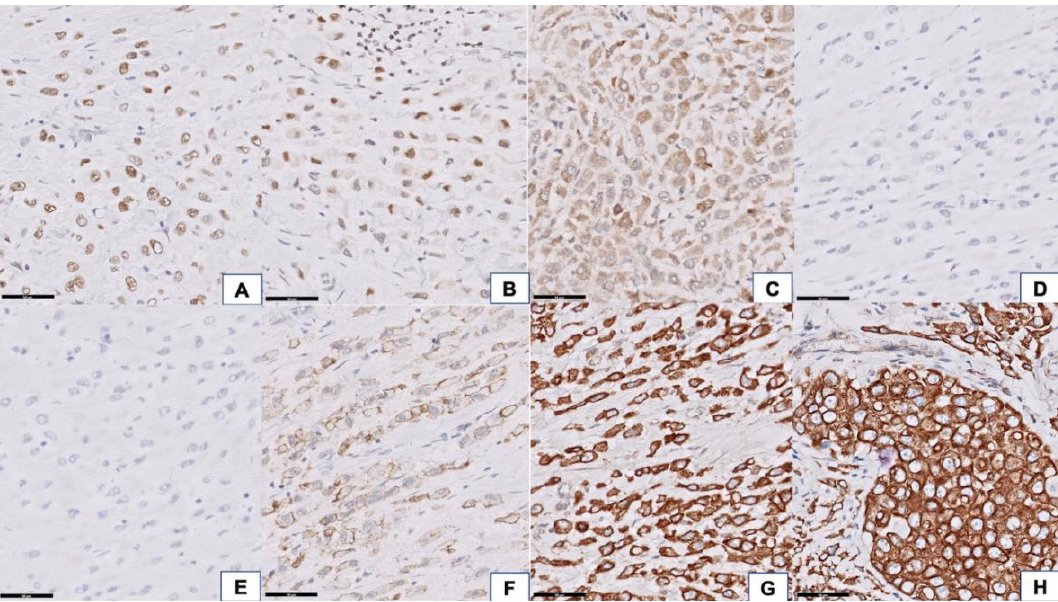
Figure 3. Immunohistochemical features of the tumor. The tumor cells showed focal moderate positivity for androgen receptor (AR) ( A ) 400 × magnification, GATA binding protein 3 (GATA3), ( B ) 400 × magnification, and gross cystic disease fluid protein-15 (GCDFP15, ( C ) 400 × magnification) and negativity for estrogen receptor (ER), ( D ) 400 × magnification, and progesterone receptor (PR), ( E ) 400 × magnification. Her2-Neu stain exhibited moderate complete staining in 40% of the tumor cells ( F ) 400 × magnification. Preserved of E-cadherin membranous staining, ( G ) 400 × magnification, with